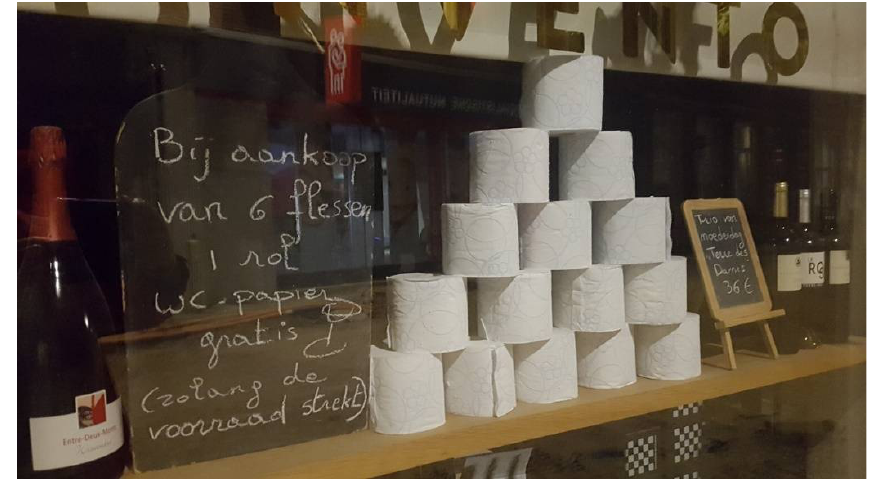
Figure 7. One roll of toilet paper for free when you buy six bottles of wine.